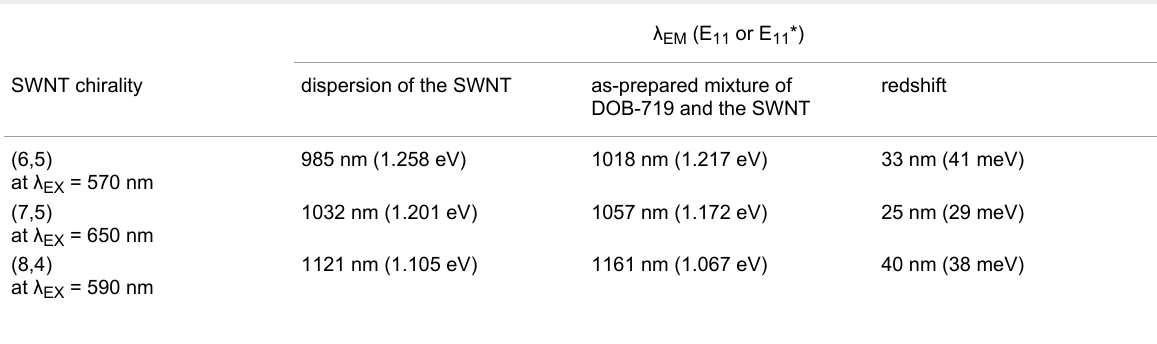
Table 1: Peaks of intrinsic PL emission (E 11 ) for the neat SWNT dispersions and the as-prepared mixtures of DOB-719 with SWNTs, redshifts of E 11 in PL due to an admixture of the